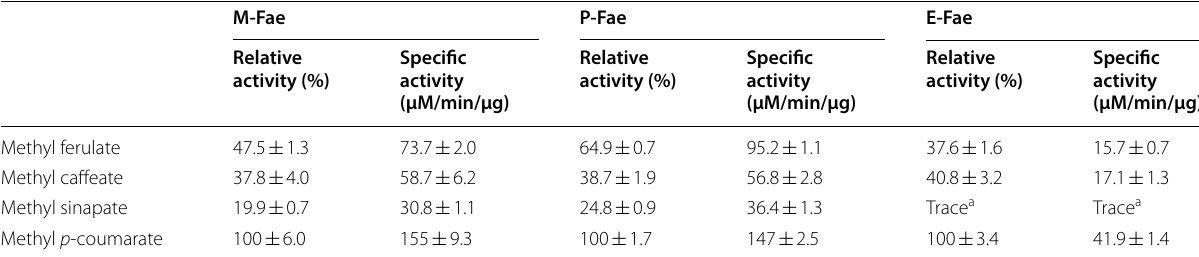
Table 1 Relative and specific activities of the three MtFae1a versions on FAE model substrates